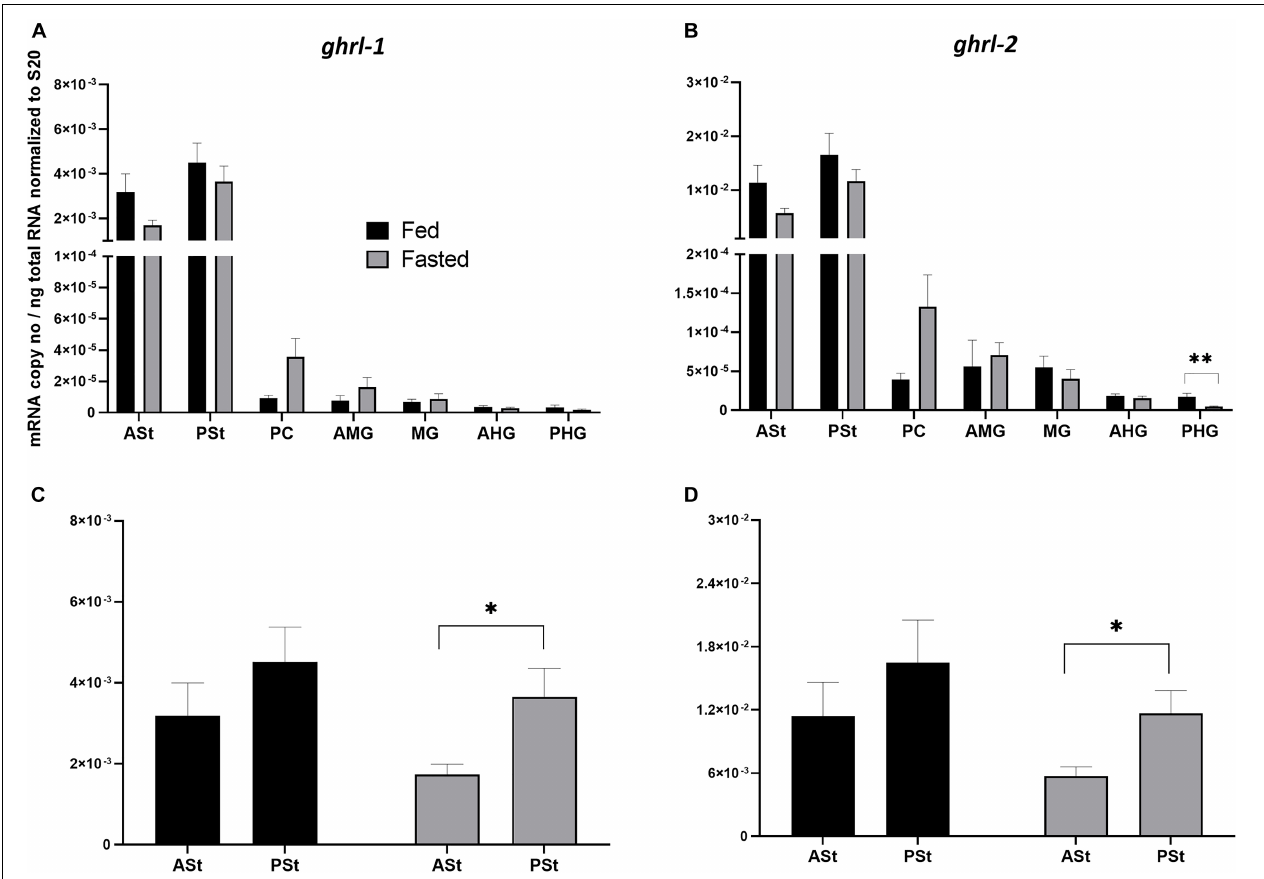
FIGURE 2 | (A,B) Comparison of mRNA expression levels of (A) ghrl-1 and (B) ghrl-2 between fed (control) and 4-day fasted groups along the GIT. (A) Data are presented as mean ± SE [ n = 12 per group, except for ASt fasted, PSt fed, PC fed, AMG fed, MG fed, AHG fed, and PHG fasted ( n = 11), and PC fasted ( n = 10)] of the normalized expression using the reference gene s20 . (B) Data are presented as mean ± SE [ n = 12 per group, except for ASt fasted, PSt fed, PC fed and fasted, AMG fed and PHG fasted ( n = 11), and AMG fed ( n = 10)] of the normalized expression using the reference gene s20 . Statistical analysis: unpaired t -test. (C,D) Comparison of mRNA expression levels between the two stomach segments (ASt and PSt) and the two groups (control and 4-days fasted) for (C) ghrl-1 and (D) ghrl-2 . Two-way ANOVA showed a significant effect of stomach segments [ F (1, 41) = 9.753; p < 0.01] but not presence/absence of food [ F (1, 41) = 0.3178; p > 0.05] for ghrl-1 ; a significant effect of stomach segments [ F (1, 42) = 9.295; p < 0.01] but not the presence/absence of food [ F (1, 42) = 0.2875; p > 0.05] for ghrl-2 . A Sidak’s multiple comparisons test was used to assess for specific pair-wise differences. ASt, anterior stomach; PSt, posterior stomach; PC, pyloric